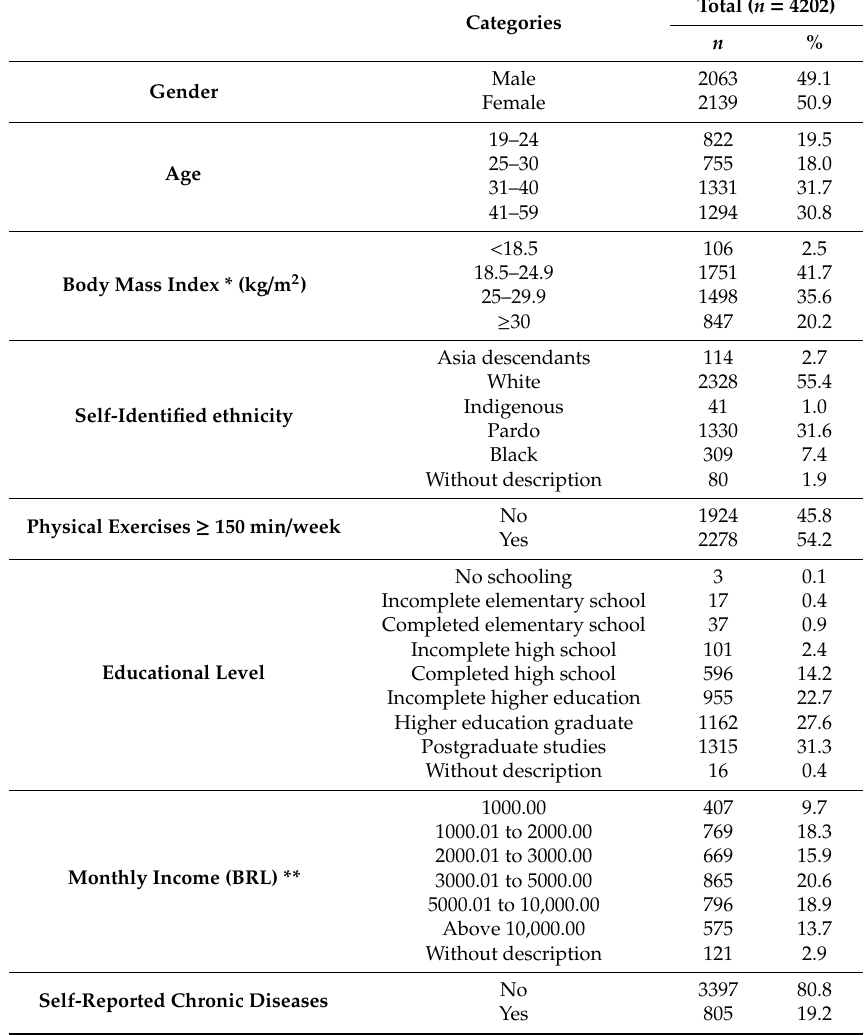
Table 2. Sociodemographic data, sample profile of the Ca ff EQ-BR study